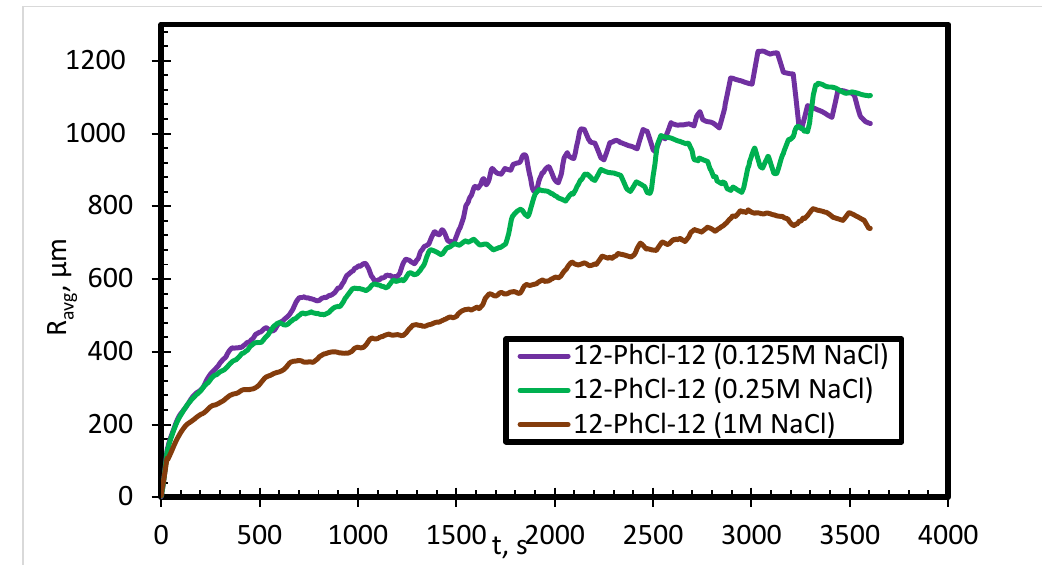
Processes 2019 , 7 , x FOR PEER REVIEW Figure 8. Effect of salinity on the bubble size of the foam generated using 12-PhCl-12. Figure 8. E ff ect of salinity on the bubble size of the foam generated using 12-PhCl-12.